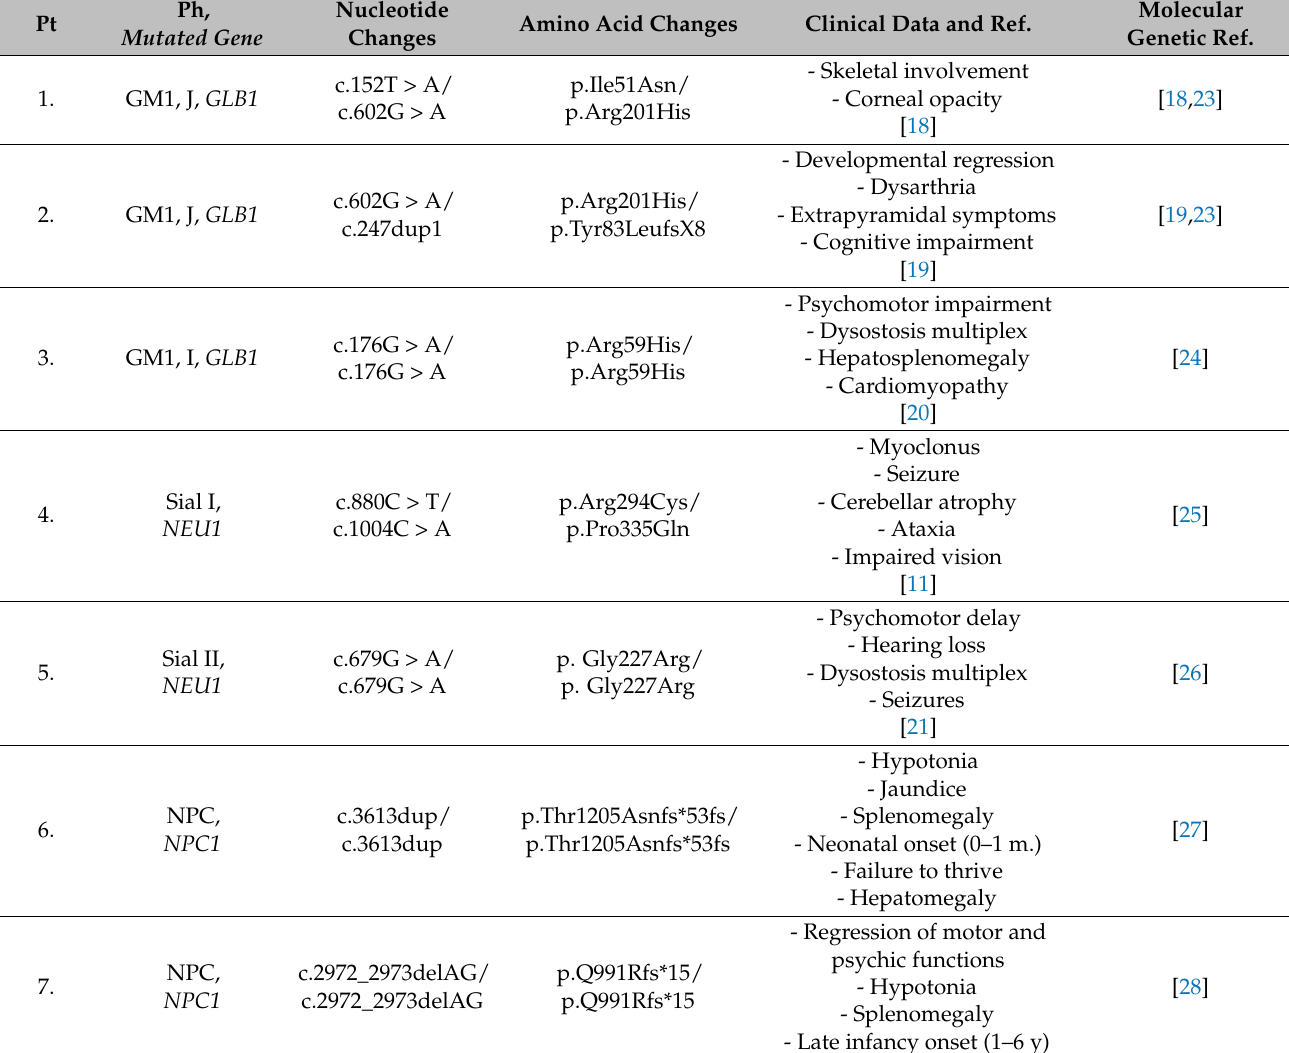
Table 1. Clinical and molecular genetic findings of analyzed